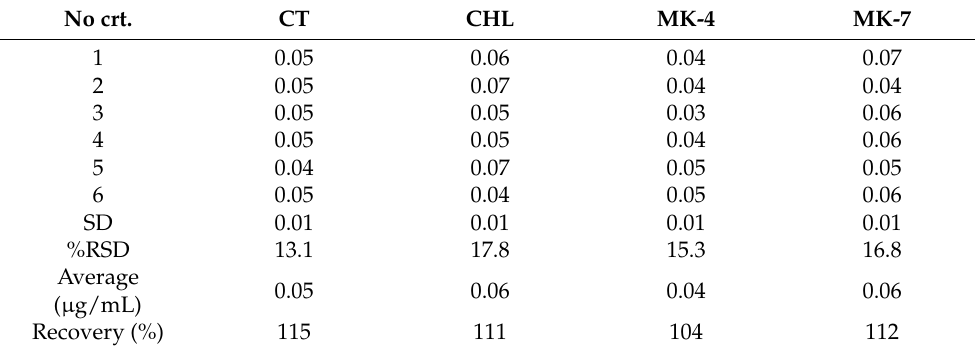
Table 3. Repeatability and recovery for the limit of quantification (LOQ). No